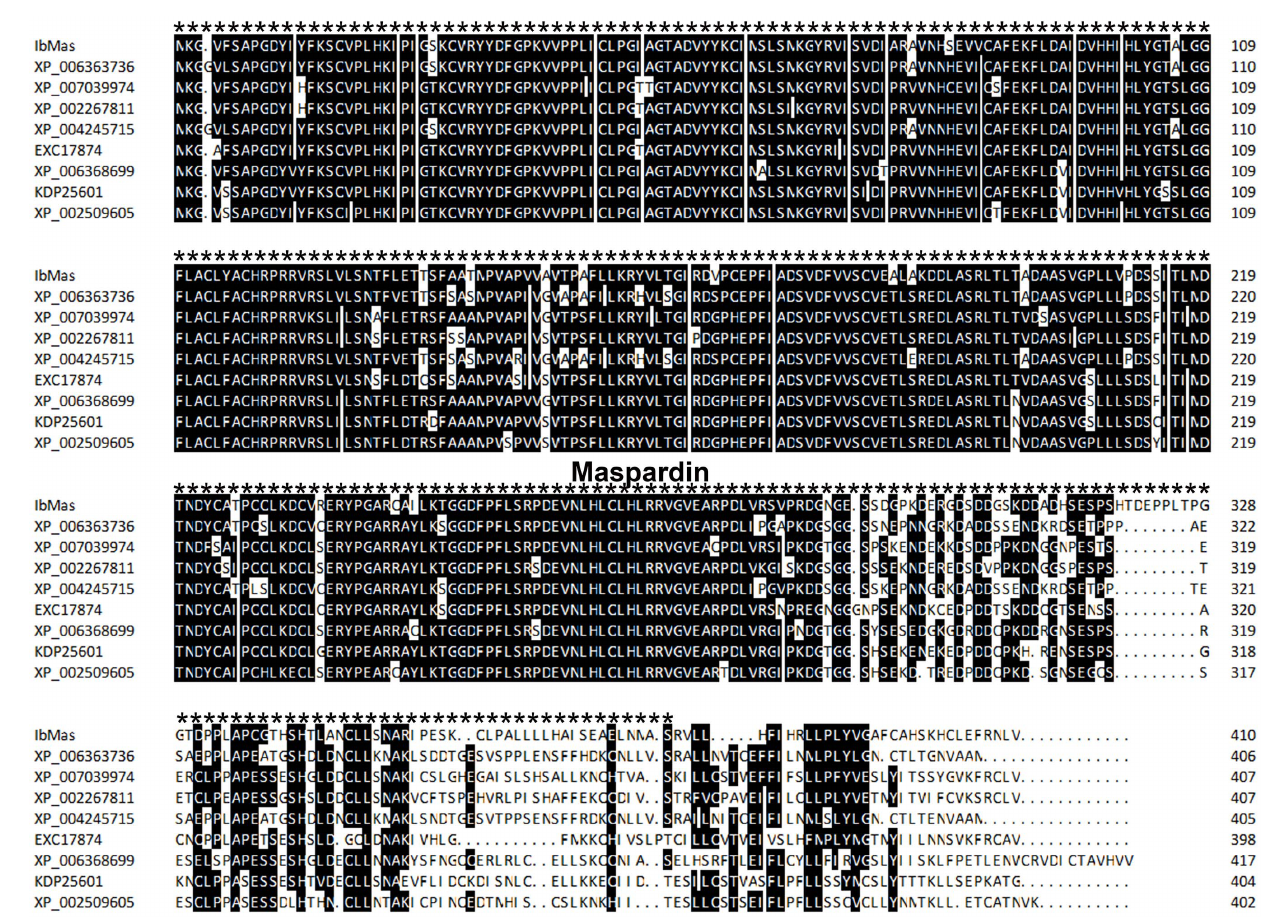
Fig. 1. Sequence alignment of IbMas protein with its homologous proteins from various plant species. The proteins are as follows: XP_006363736 from Solanum tuberosum , XP_007039974 from Theobroma cacao , XP_002267811 from Vitis vinifera , XP_004245715 from Solanum lycopersicum